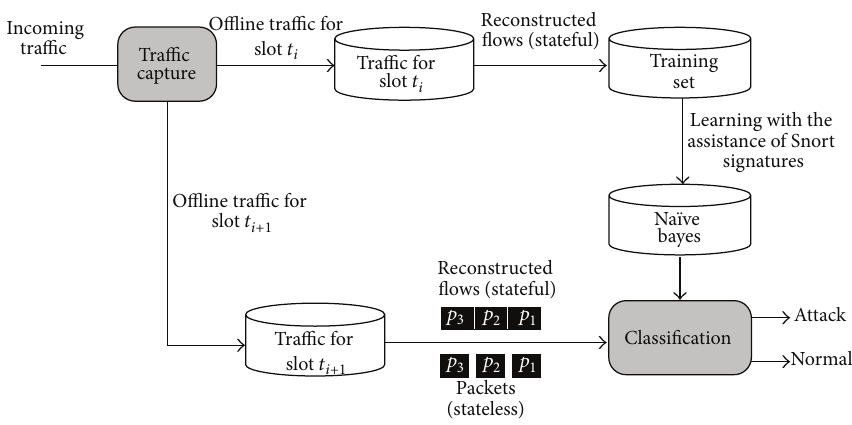
Figure 6: The proposed malware detection system.